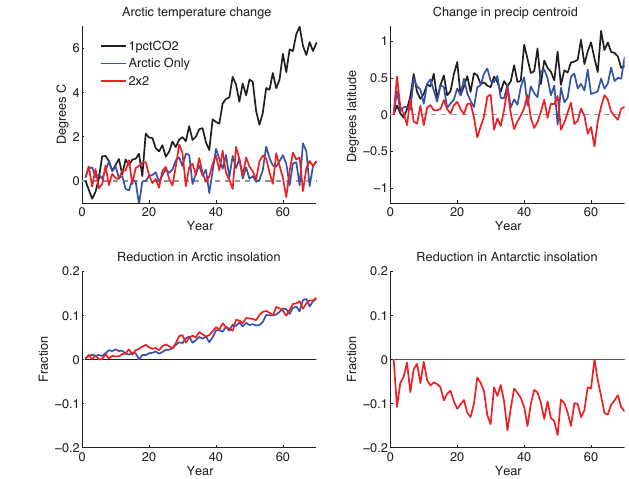
Figure 12. Results for the 2 × 2 case in the design model. Black lines indicate the 1pctCO2 simulation. The feedback algorithm ad- justs Arctic and Antarctic insolation (bottom-left and bottom-right panels, respectively) to offset these changes, returning Arctic tem- perature (top-left panel) and (for the 2 × 2 case) the precipitation centroid ( χ , Eq. 1; top-right panel) to the dashed grey lines. Blue lines indicate simulations in which only Arctic insolation is ad- justed. Red lines indicate the full 2 × 2 case.